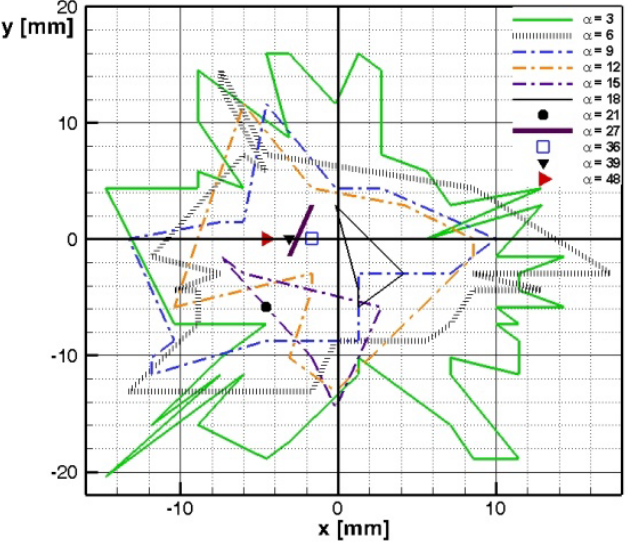
Figure 5. Polygon of frequencies ( α ) of certain vortex center positions in the measuring section.